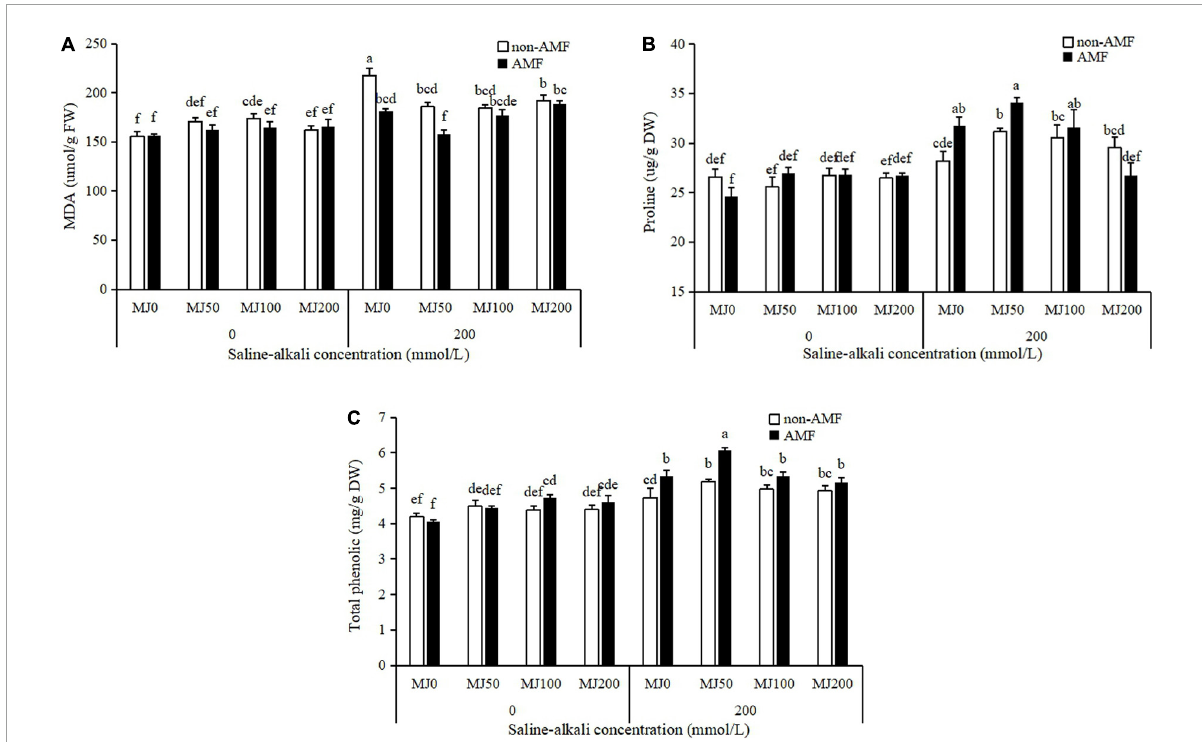
FIGURE4 Malondialdehyde (MDA) (A) , proline (B) , and total phenolic (C) concentrations of tall fescue as effects by the interaction between arbuscular mycorrhizal fungi (AMF), different methyl jasmonate (MeJA) levels (0 MeJA = 0 mg/L, 50 MeJA = 50 mg/L, 100 MeJA = 100 mg/L, 200 MeJA = 200 mg/L) and saline-alkali stress. Different letters above the bars indicate significant differences according to Duncan’s multiple range test ( P ≤